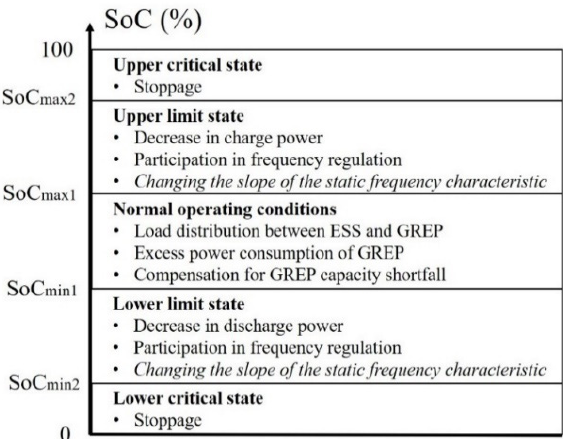
Figure 11. Graph of the division of the range of SoC values into areas of ESS operation.